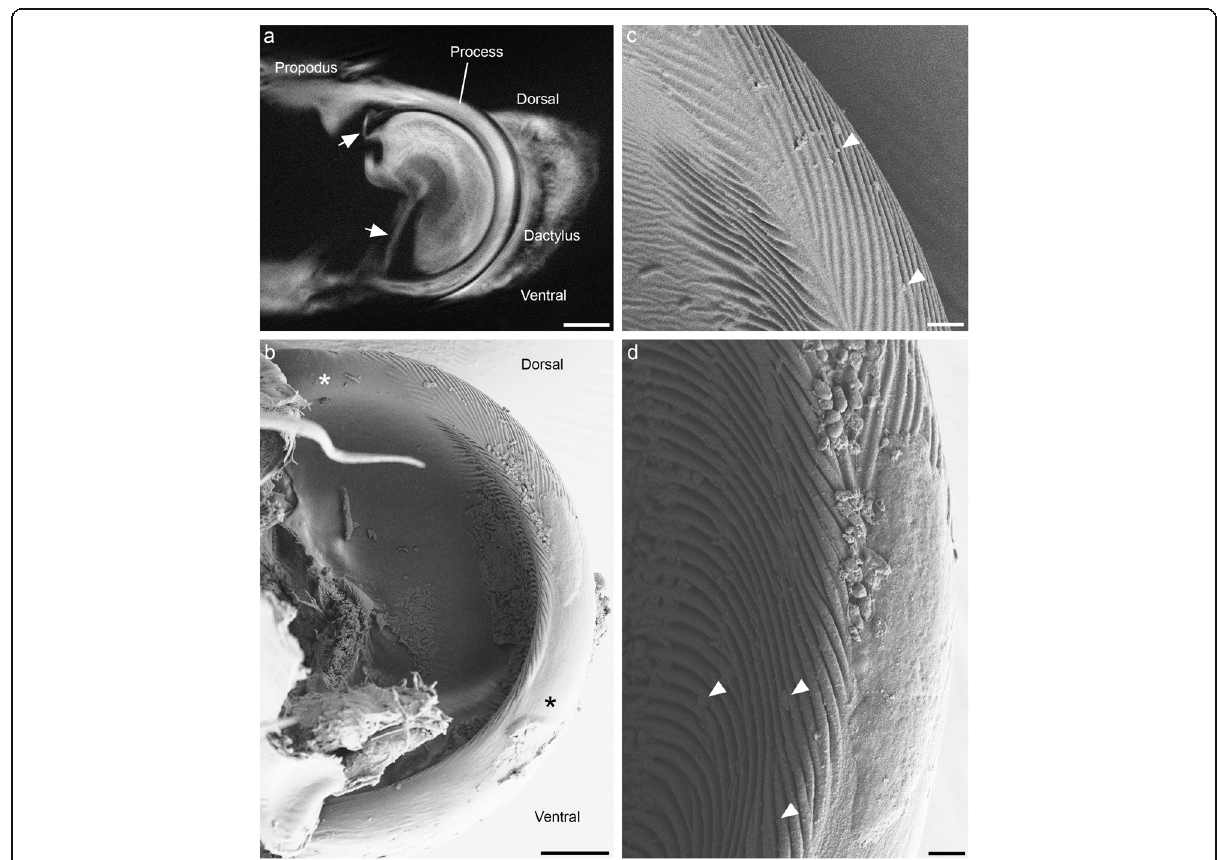
Fig. 4 Structure of the propodal process. a Optical section through an intact propodus-dactylus joint illustrating how the edge of the propodal process fits into the groove of the dactylus. An arthrodial membrane (arrows) connects the two podomeres. b Scanning electron micrograph of the propodal process with the dactylus removed. The tip of the propodus ends with a semicircular cuticular plate with a thickened edge. Parallel ridges are present on the concave surface of the thick edge; on its convex surface, they are only present dorsally. The convex surface of the ventral half of the edge and the concave surface of its most dorsal part are smooth (asterisks). c Higher magnification image of the dorsal part of the propodal process, showing the oblique ridges arranged in a herringbone pattern. Arrowheads point to particles lodged between the ridges on its surface. d Detail of the ventral part of the edge, showing the ridges on its concave surface and its smooth convex surface. Particles are visible between the ridges (arrowheads). Scale bars: 20 μ m (a), 10 μ m (b), 2 μ m (c and